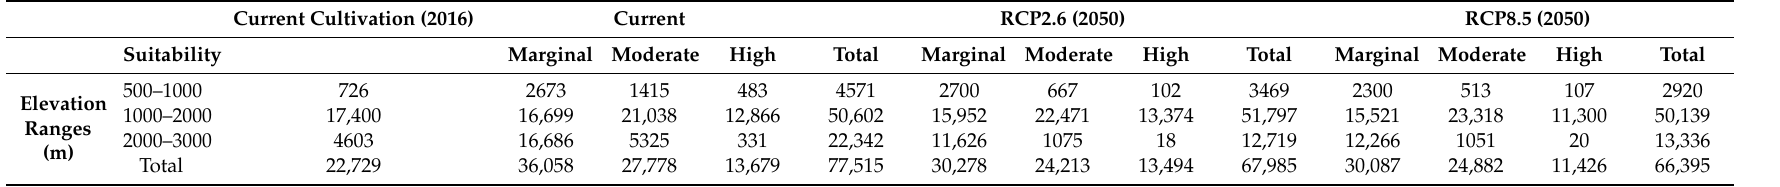
Table 2. Areas (ha) of habitat suitability under di ff erent scenarios with elevation